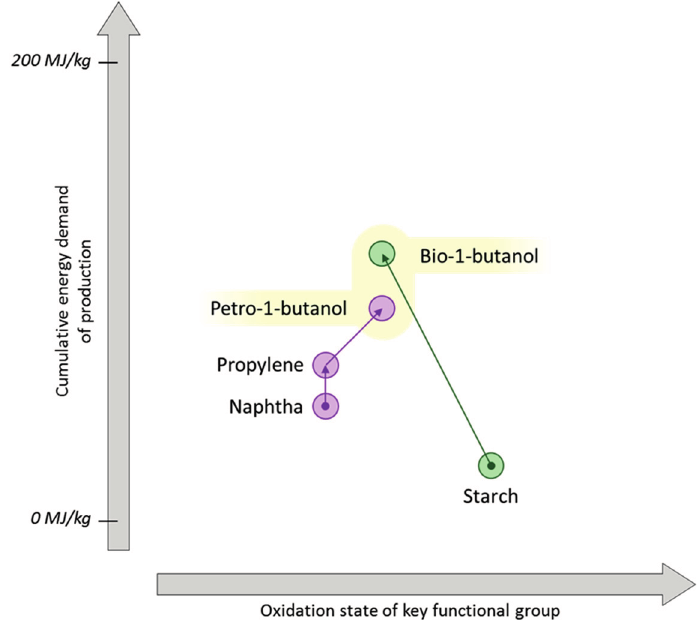
Figure 14. The cumulative energy demand of 1-butanol